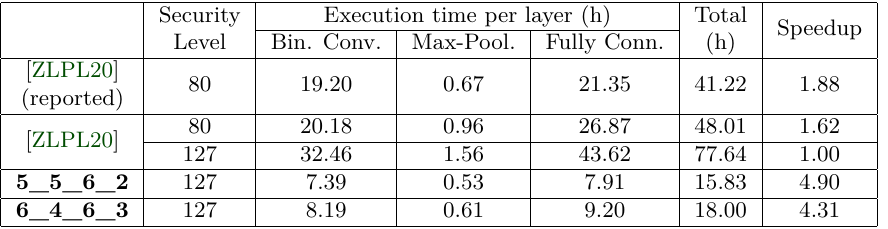
Table 9: Estimation of an inference on the Binarized CNN of Zhou et al.